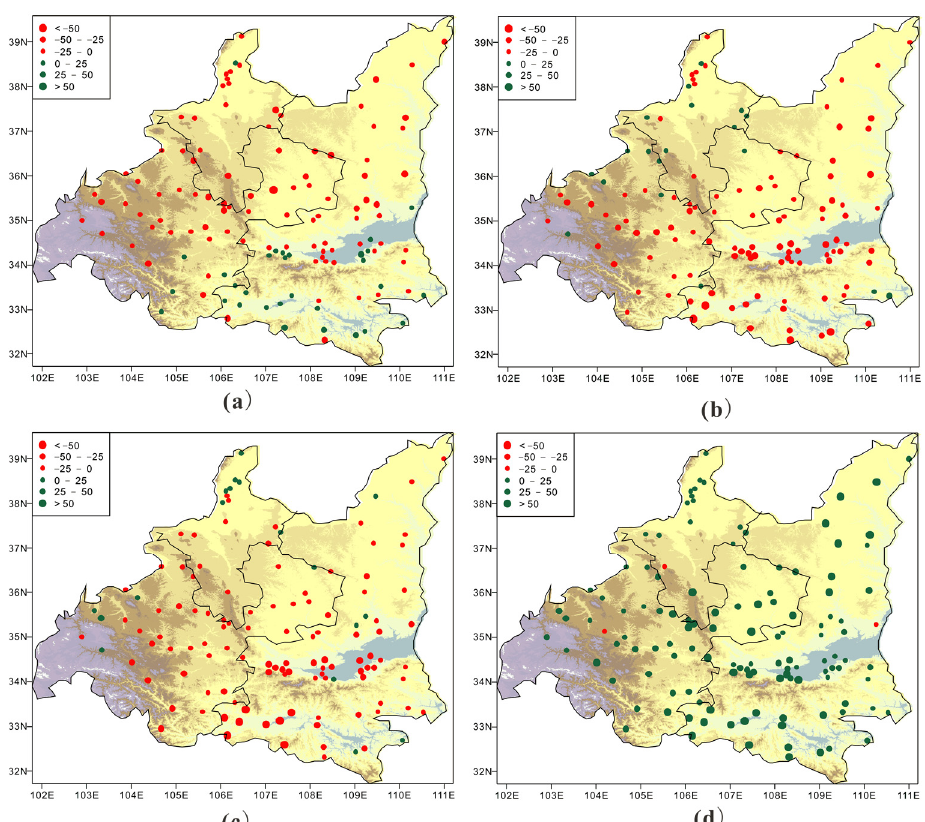
Figure 7. Annual precipitation change rate in different time periods (unit: mm/10 years): ( a ) 1961– 1990; ( b ) 1971–2000; ( c ) 1981–2010; ( d )